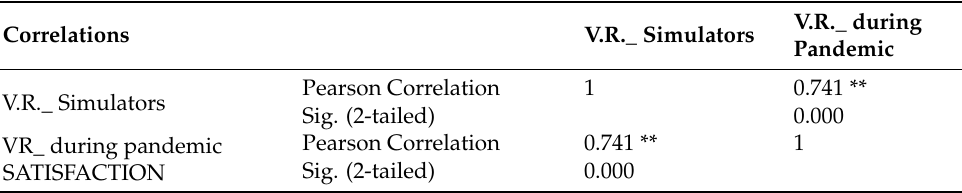
Table 7. Karl person test significance difference between using virtual reality simulators for medical education during COVID-19. Correlations V.R._ Simulators